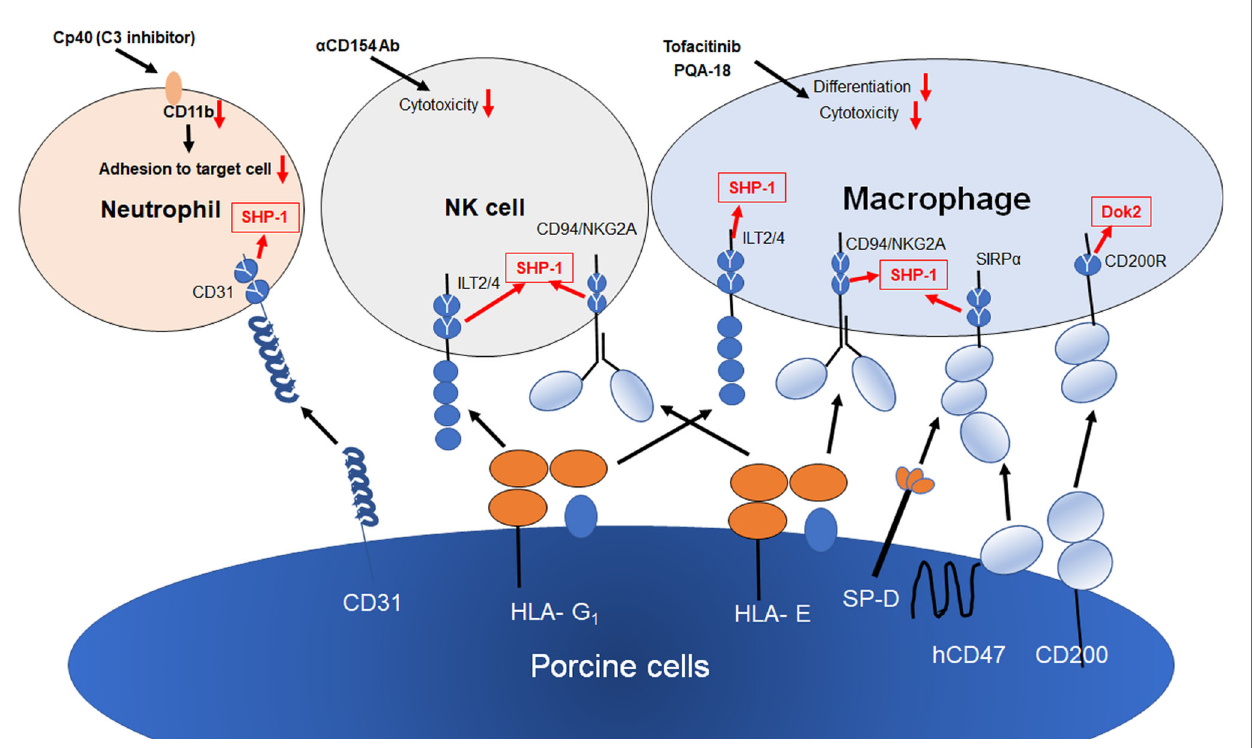
FIGURE 2 | Strategies for innate cellular xenogeneic rejection. Both HLA-E and G1 on porcine endothelial cells suppress NK and macrophage-mediated xenogeneic rejection. The transgenic expression of human CD47, SP-D and CD200 on porcine cells results in the suppression of macrophage-mediated cytotoxicity and in fl ammation. Human CD31 inhibits NETosis in neutrophils via the homophilic binding to CD31 on neutrophils. Both Tofacitinib (JAK inhibitor) and PQA-18 (PAK2 inhibitor) have been reported to suppress macrophage-mediated cytotoxicity and differentiation of macrophages. Anti-CD154 Ab suppress NK cytotoxicity against CD40 + target cells. Cp40 (C3 inhibitor) suppress CD11b expression, resulting in suppression of neutrophil adhesion to porcine cell. Y shows an inhibitory intracellular signaling motif of inhibitory